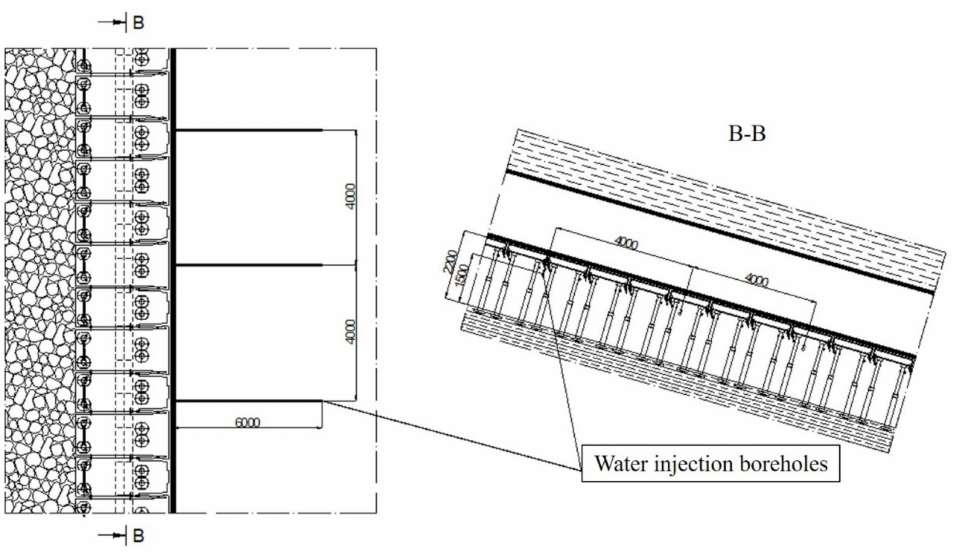
Figure 4. Schematic layout sketch of water infusion